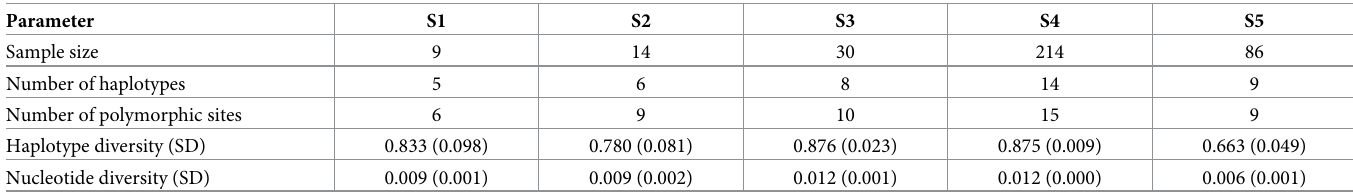
Table 2. Mitochondrial DNA variation parameters calculated in subpopulations identified by SAMOVA. See Fig 5 for spatial distribution of subpopulations S1–S5. Parameter S1 S2 S5 Sample size Number of haplotypes Number of polymorphic sites Haplotype diversity (SD) Nucleotide diversity